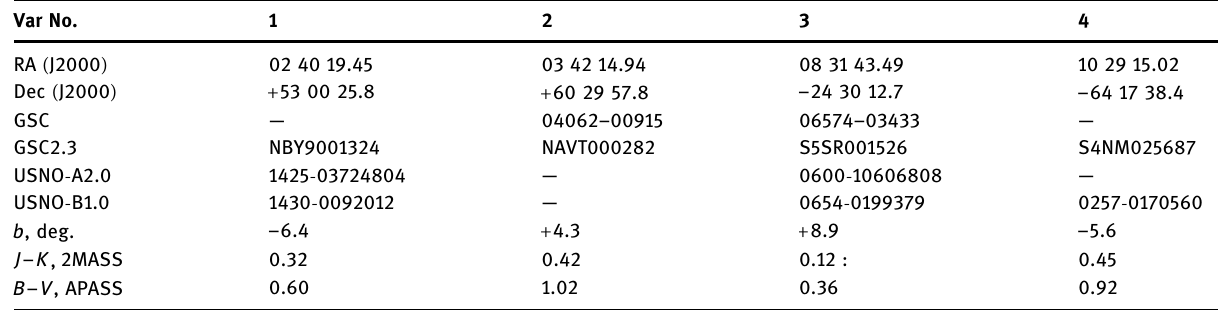
Table 1: General information on the variables Var